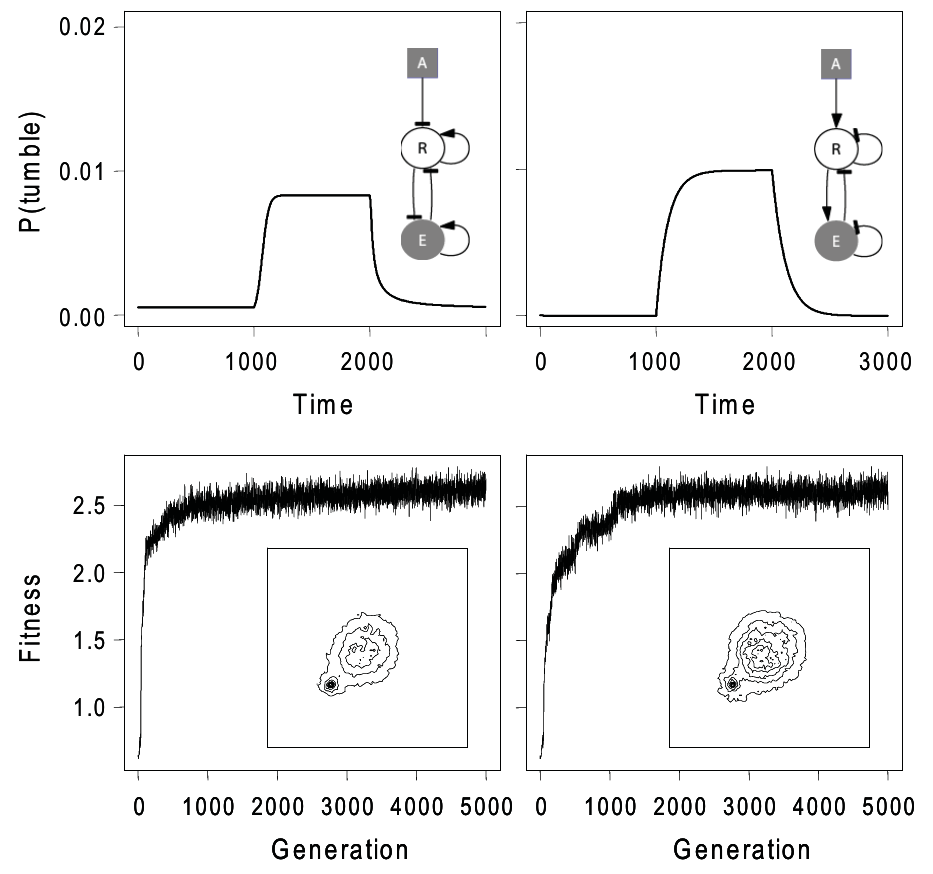
Figure 4. Minimal pathways with non-adaptive dynamics. Cartoon representation and time course of active effector concentration for the most frequent and unique pathways with 2 proteins obtained from 5 different evolutionary simulations. The pathway on the left and right were found in 1 and 4 simulations, respectively. Bottom panels show fitness curves for the corresponding simulations and the time-averaged distribution of positions of the final population. Kinetic parameters for these pathways are given in Dataset